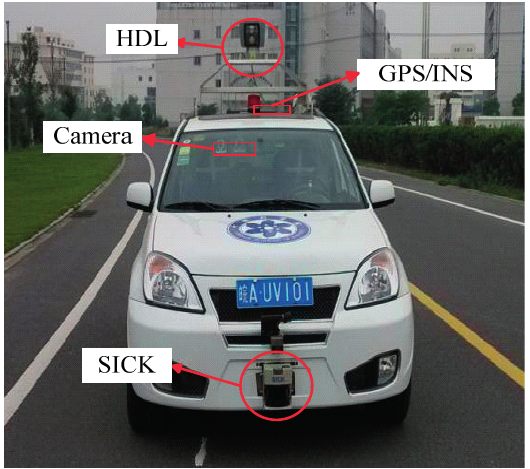
Figure 1. The autonomous vehicle named “Intelligent